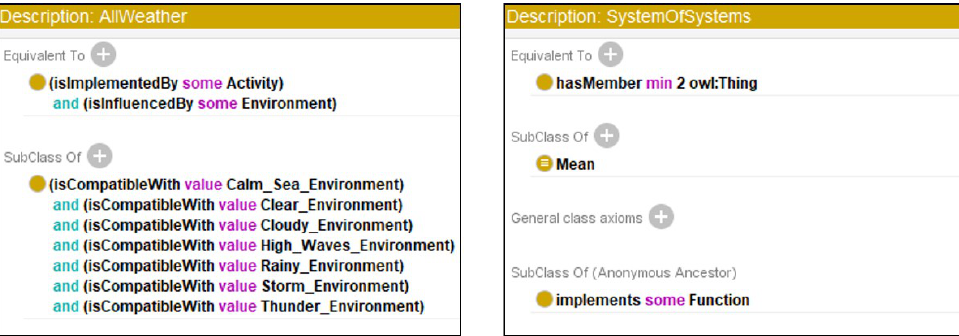
Figure 16. The definitions of the AllWeather class ( left ) and the SystemOfSystems class ( right